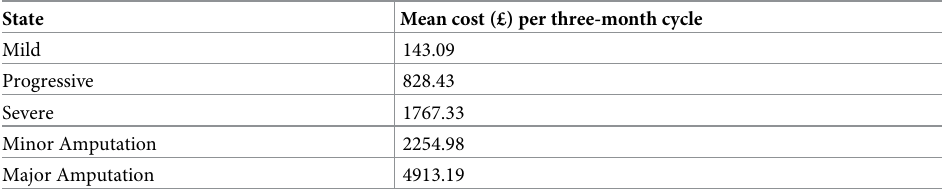
Table 3. The Markov state mean cost per cycle, by level of model state